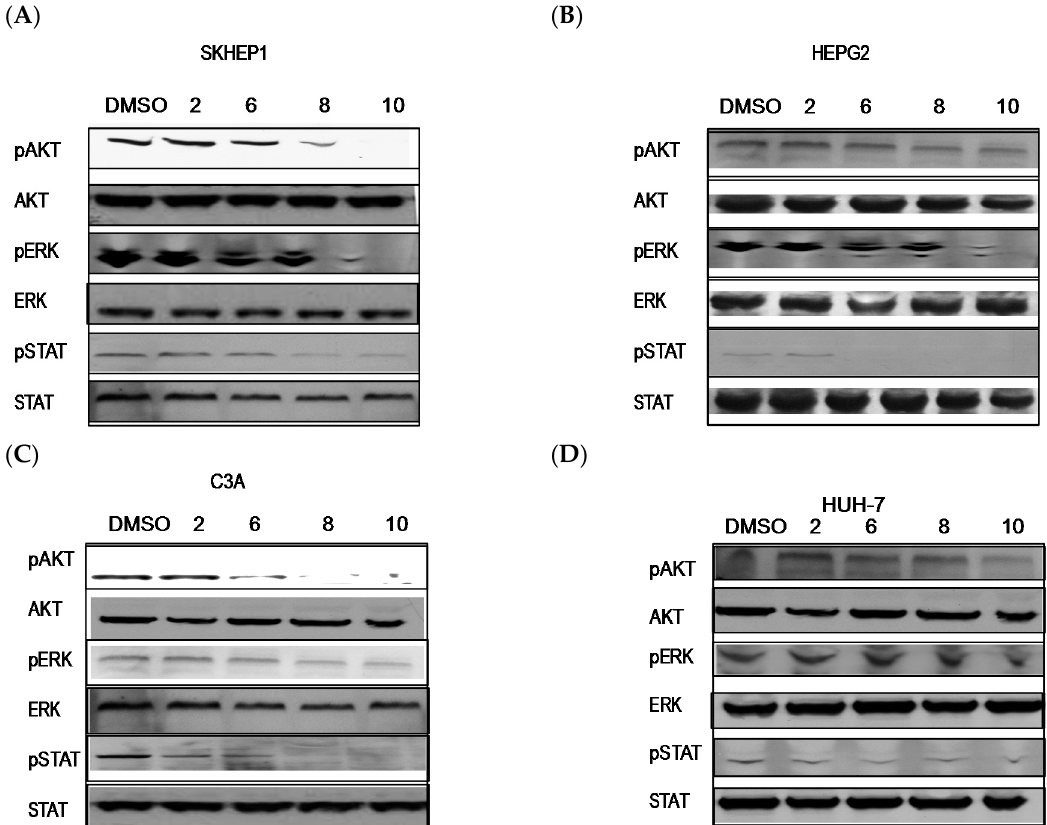
Figure 4. PBISe inhibits AKT/PI3K, MAPK/ERK and STAT3 signaling in human HCC. Four different